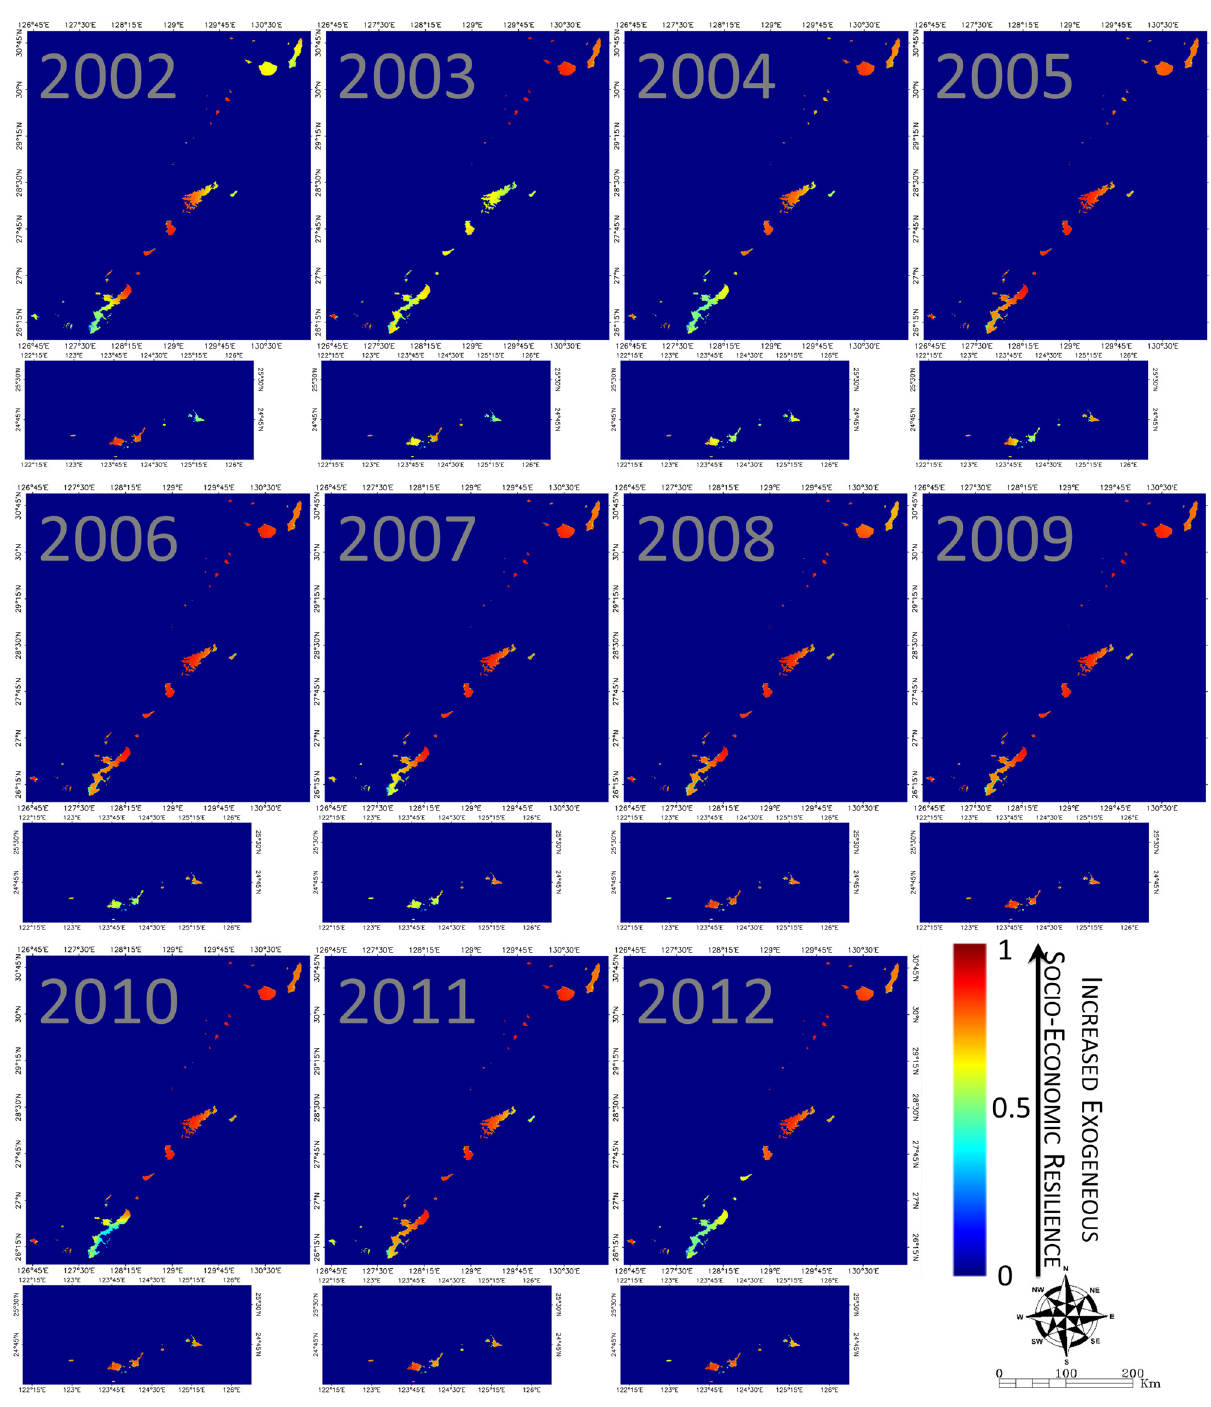
Figure 4. Nansei maps of the exogenous socio-economic resilience during 2002–2012. The resilience index was based on a suite of combined oceano-climatic and elevation factors using a fuzzy logic approach. For each year, the investigation of the Nansei region focused on the northern and southern parts (see the two study areas in Figure